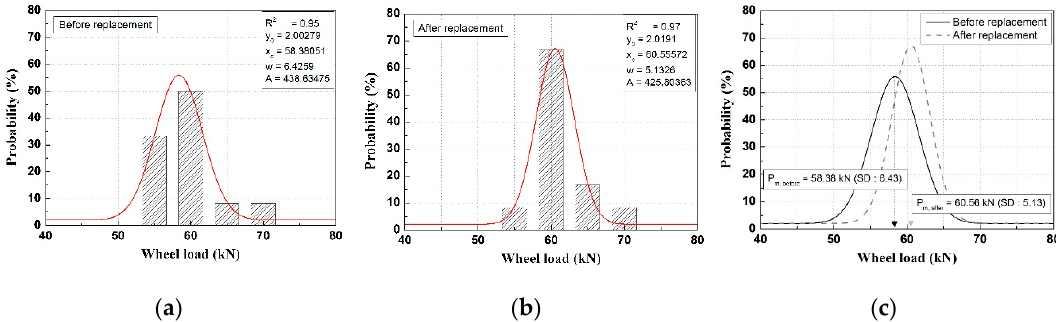
Figure 5. Comparison of the measured dynamic wheel load according to rail pad replacement. ( a ) Before rail pad replacement; ( b ) after rail pad replacement; and ( c ) dynamic wheel load fluctuation for before and after rail pad replacements.